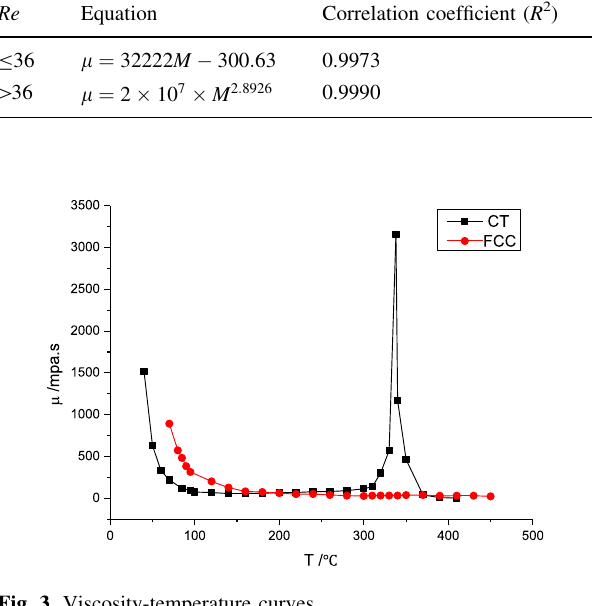
Fig. 3 Viscosity-temperature curves